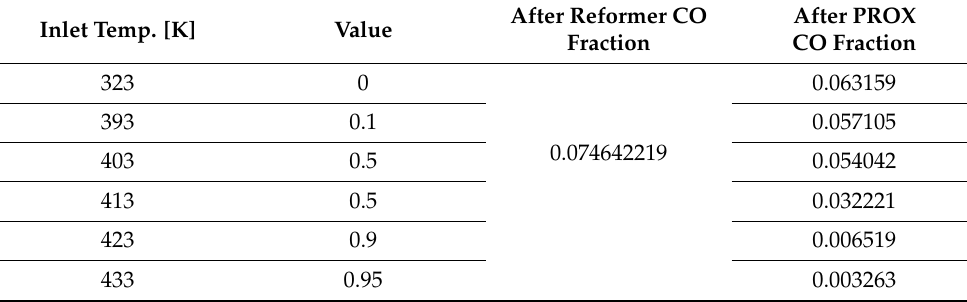
Table 2. PROX efficiency according to inlet